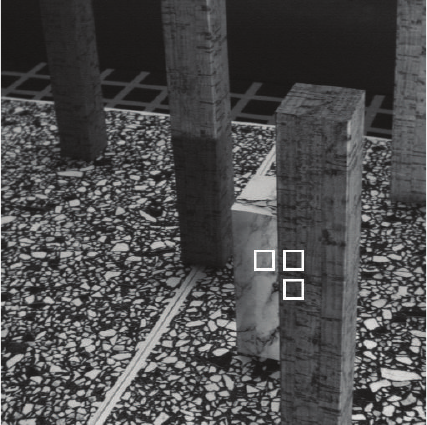
Figure1:AframeoftheMarbled-Blockimagesequencewherethree local areas, two on one column having the same motion and one on a different column with distinctly different motions, are highlighted by white rectangles. The main question here is to predict the least amount of relative motion between the two columns that would make those definitely separable by their